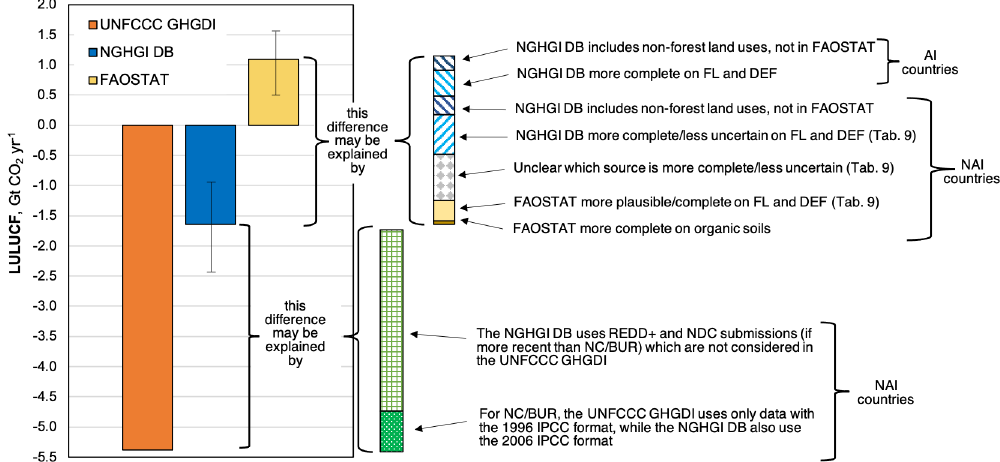
Figure 7. Disaggregation of the differences in net global LULUCF CO 2 fluxes (average 2000–2020) between the NGHGI DB presented in this study and FAOSTAT (upper right column), and between the NGHGI DB and the UNFCCC GHG data interface (UNFCCC GHGDI) (bottom right column). Whiskers indicate the estimated global uncertainty (95% confidence interval) on the net LULUCF flux for the NGHGI DB (see Methods) and FAOSTAT (Tubiello et al., 2021). See text for